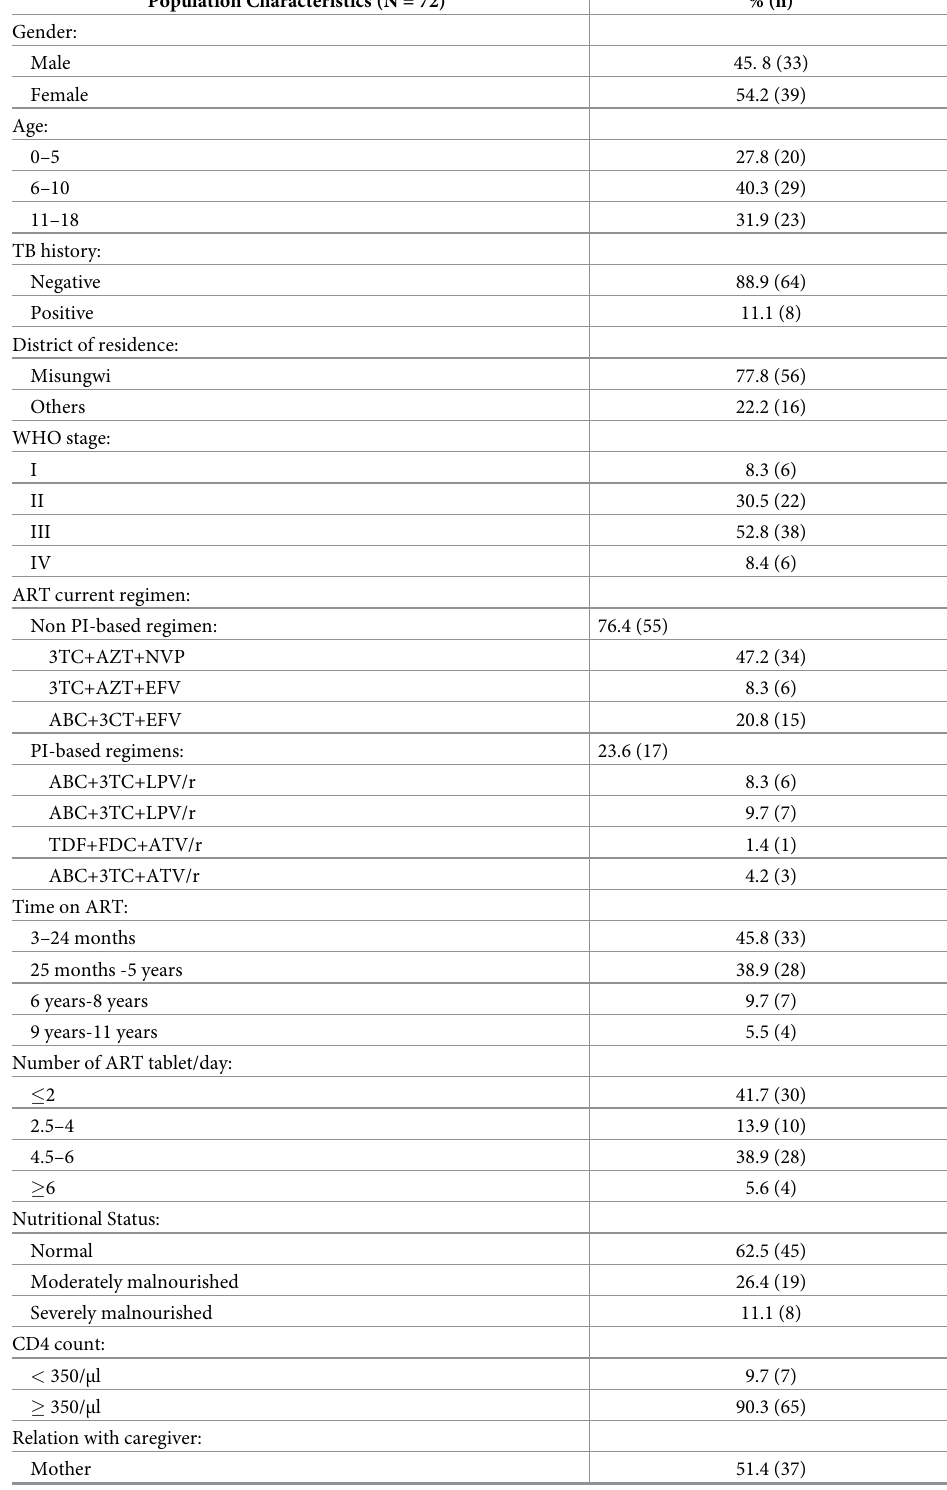
Table 1. Sociodemographic and clinical characteristics of the studied